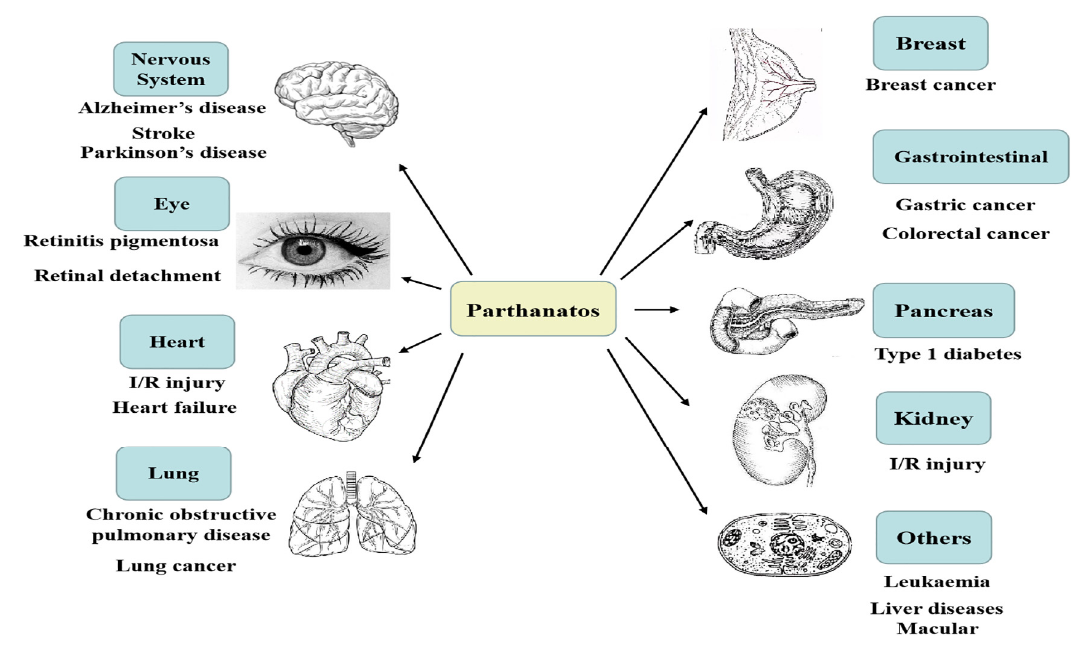
Figure 1. Parthanatos is associated with multiple system diseases; for example, nervous system diseases, heart diseases, retinal diseases, gastrointestinal diseases, lung diseases, kidney diseases, pancreatic diseases, breast diseases, and so on.